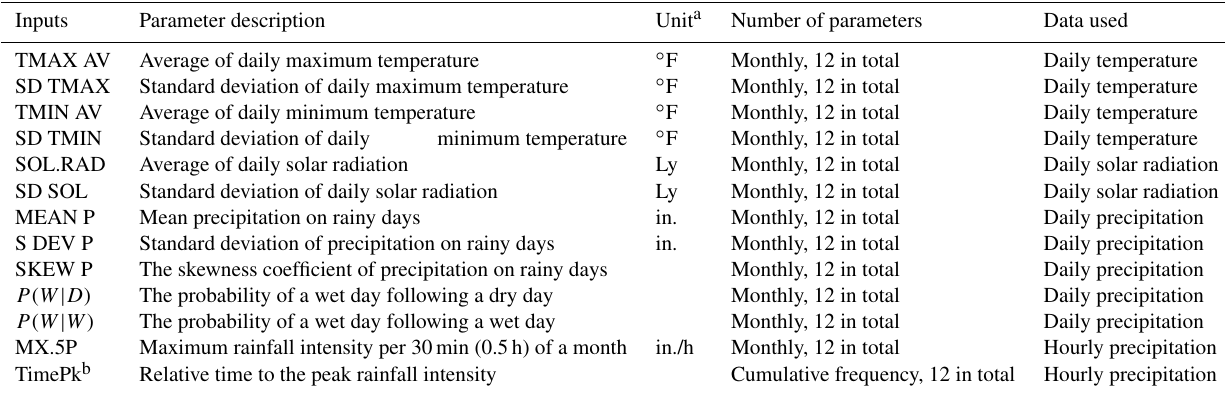
Table 1. Summary of CLIGEN input parameters and the data used for the calculation of parameters.